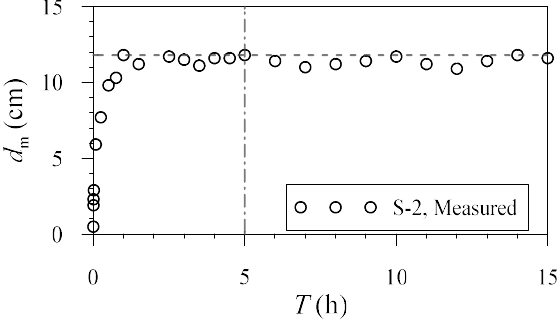
Figure 2. Maximum scour depth evolution for Run S-2.